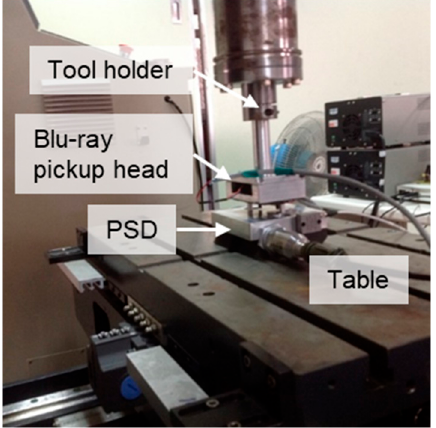
Figure 7. Schematic diagram shows the setup of the TCP − OMS on the actual machine.